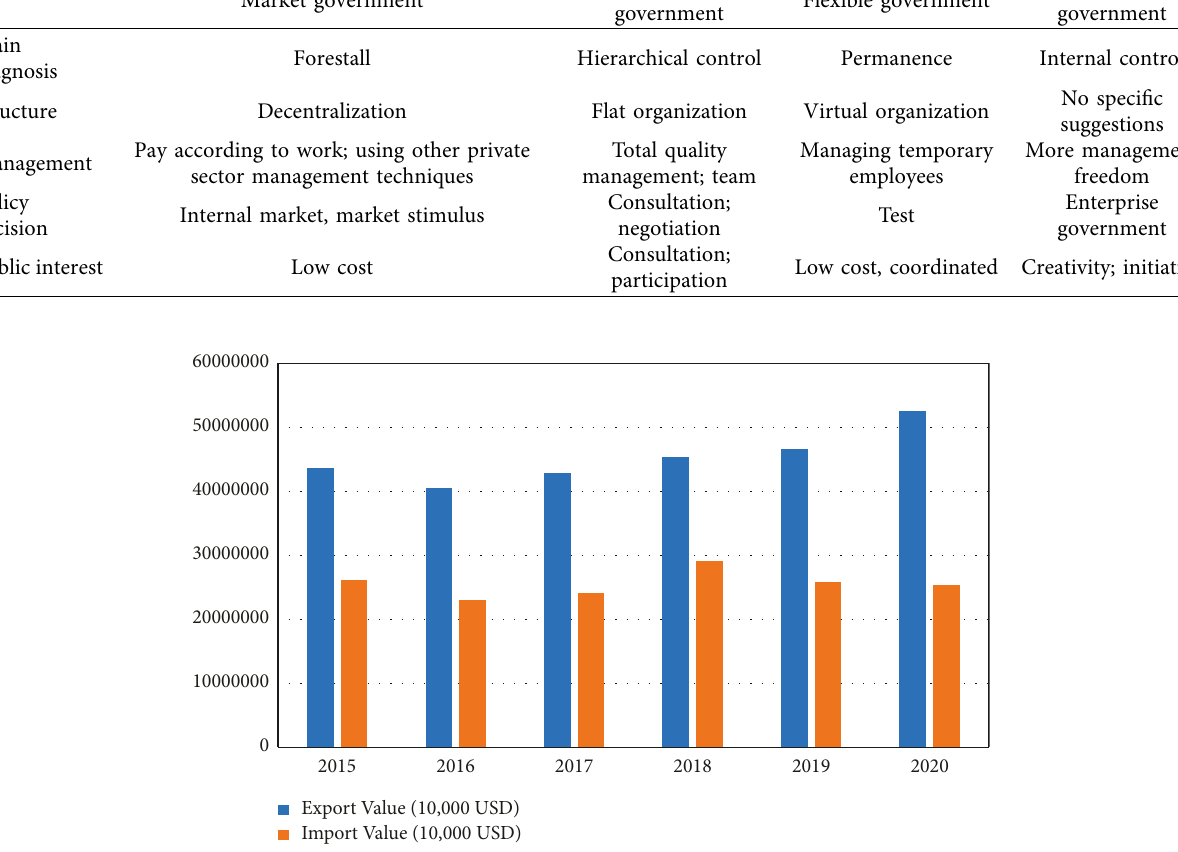
Figure 1: Shenzhen import and export